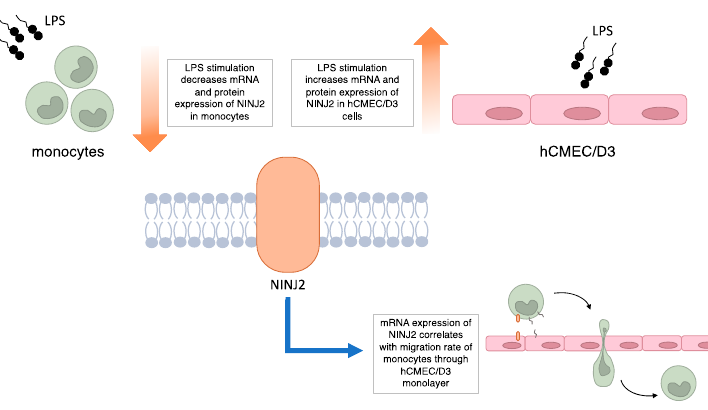
Figure 5. Summary of main findings of the study.